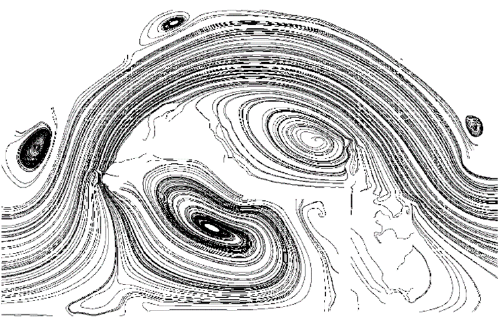
Figure 9. Streamlines from the second measurement area.